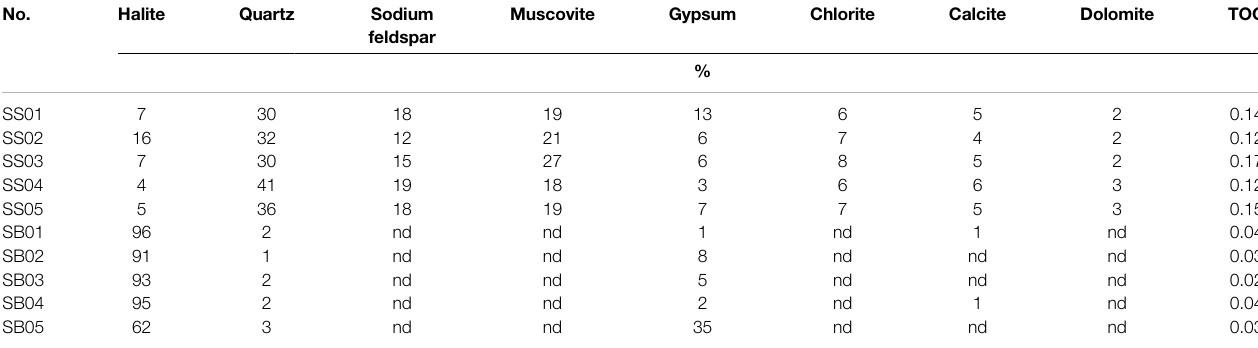
TABLE 2 | Mineral composition and TOC content in sediment samples with different lithological caharcteristics.